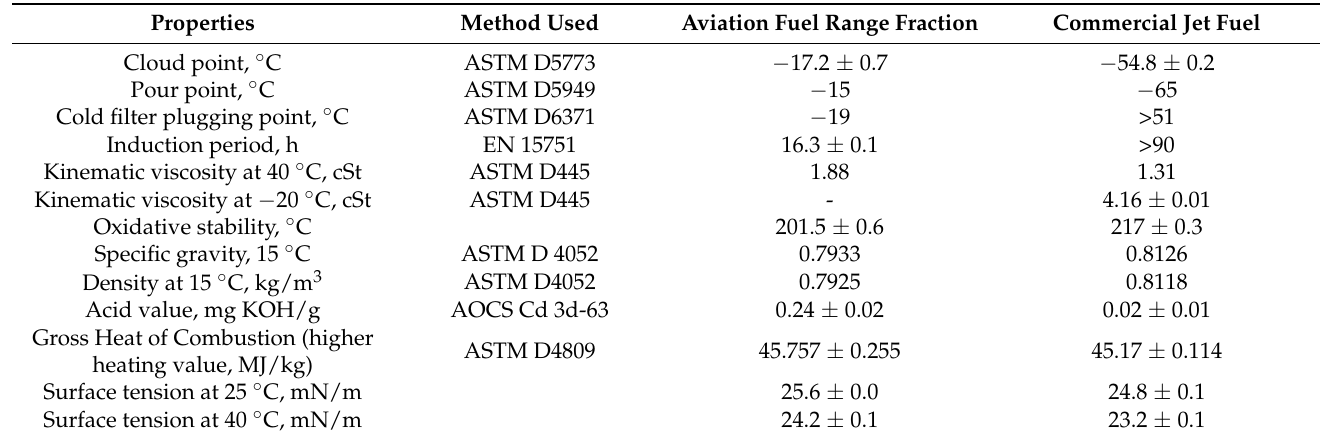
Table 10. Fuel properties of aviation range fuel fraction from PCO-LL and commercial jet